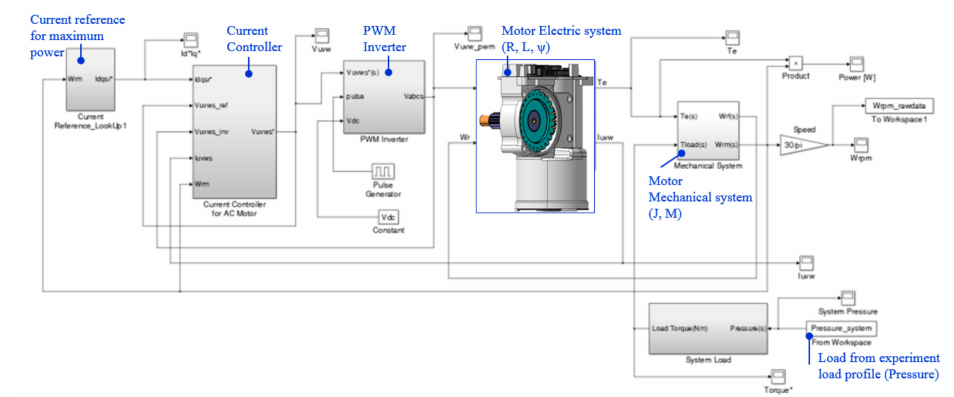
Figure 8. Current vector control strategy by using the experimental load profile.